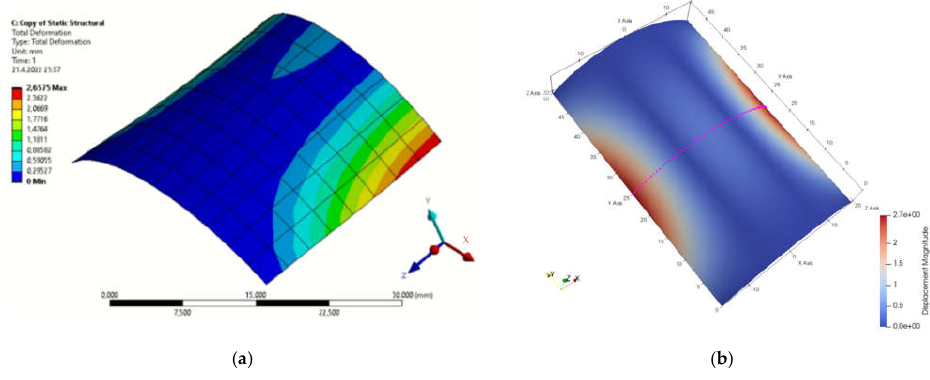
Figure 11. Total displacement field ( a ) FEM program; ( b ) MATLAB.